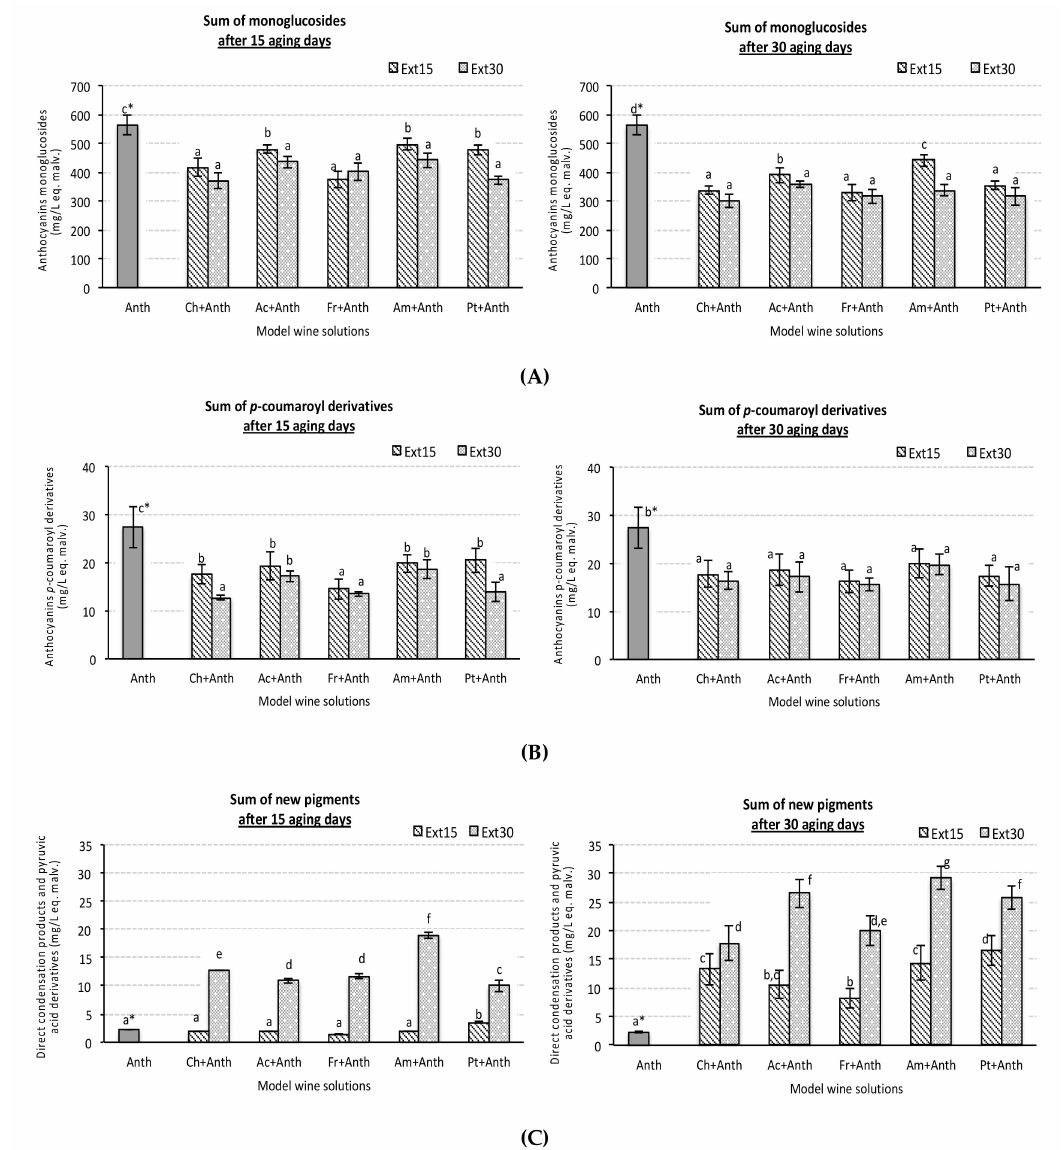
Figure 3. Sum of anthocyanins monoglucosyl derivates ( A ), sum of anthocyanins p -coumaroyl derivates ( B ) and sum of new pigments formed ( C ), quantified in experimental red synthetic wine solutions containing di ff erent wood chip extract species and anthocyanin grape skin extracts after 15 and 30 aging days (sample codes see Table 1). All data express the average of four replicates ± standard deviation; * data points showing the same letter are not significantly di ff erent ( p <